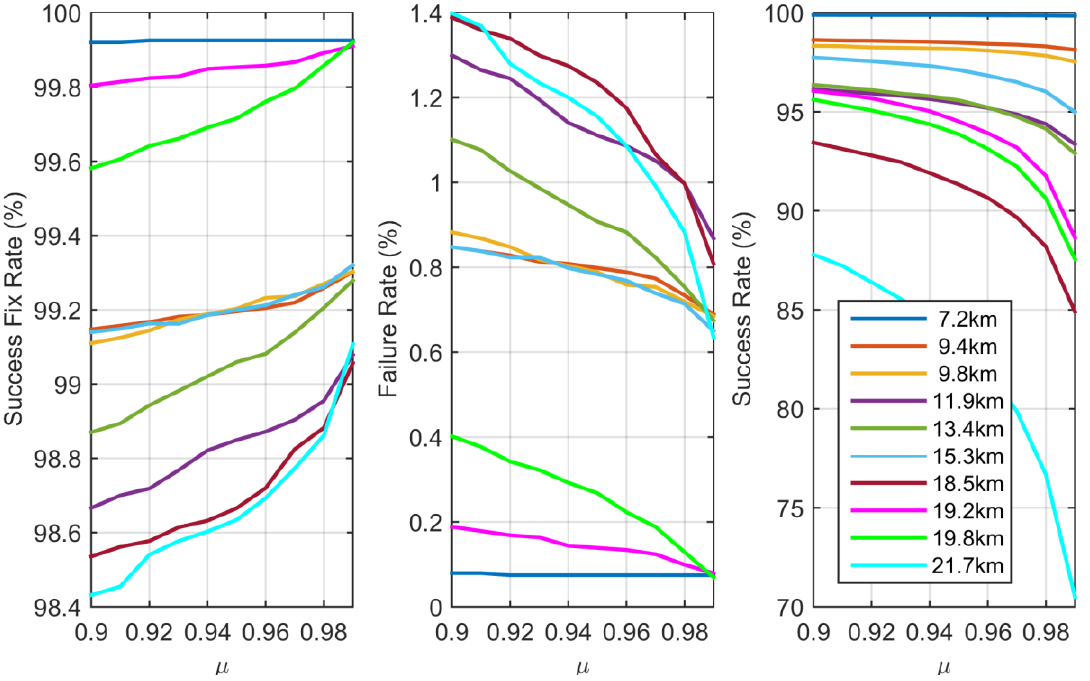
Figure 10. Success fix rate, failure rate and success rate validation of the FL-approach with different GPS baseline data.